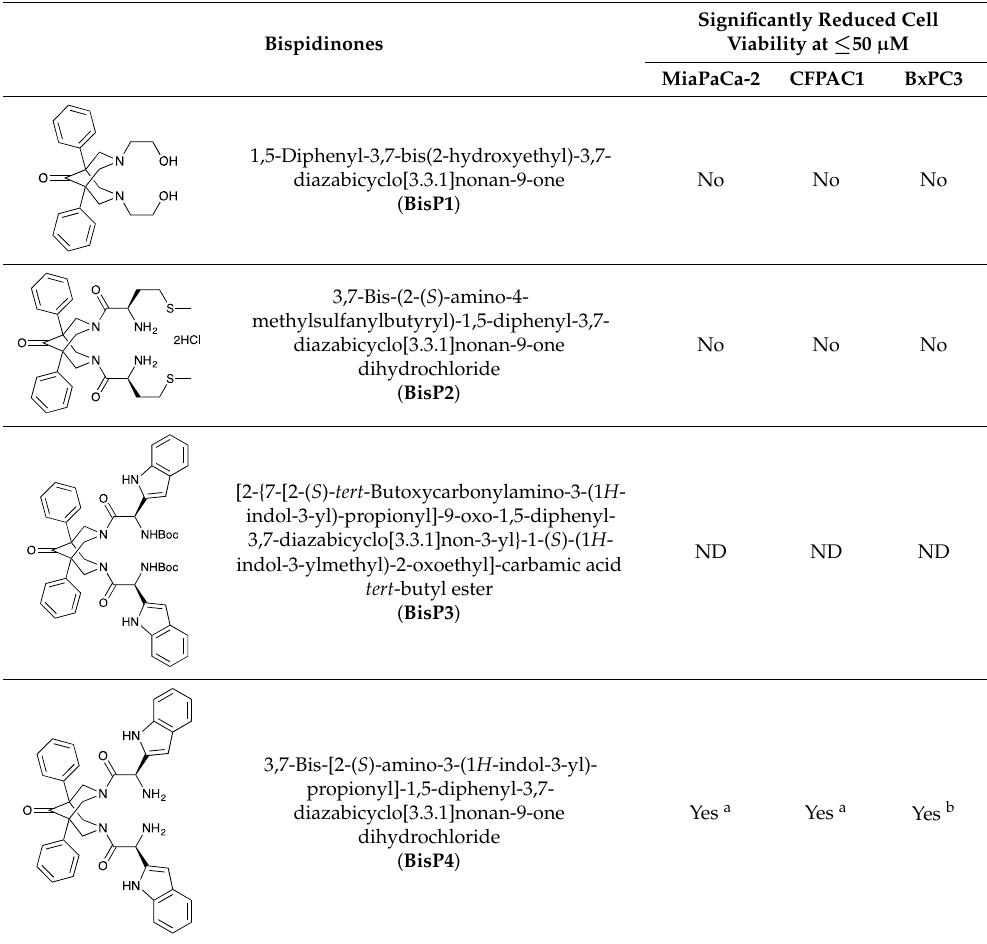
Figure 2. After 48 h treatment, derivative BisP4 had a statistically significant reduction in cell viability from all concentrations, except for 10 µM treatment on BxPC3 cells. Results are mean absorbance (cid:3399) SD, n = 6. Values for variance ( p ) between control versus treatment and gemcitabine versus treatment are respectively denoted by symbols ****, #### , p < 0.0001, ***, ### p < 0.001, **, ## p < 0.01, *, # p < 0.05, determined using a one-way ANOVA and Dunnett’s post-hoc test.